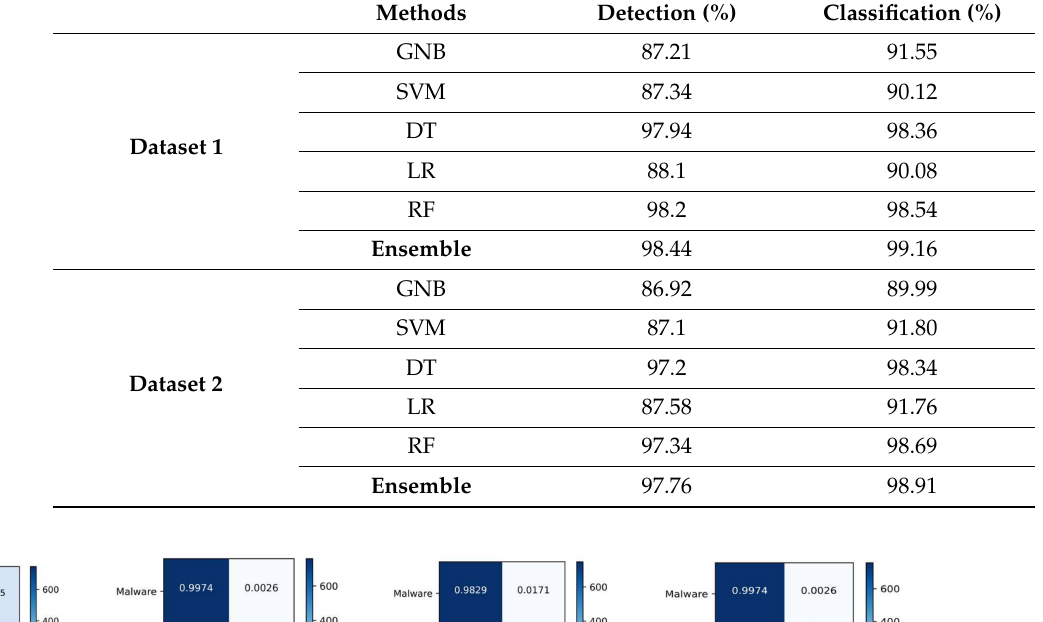
Table 5. Malware detection and classification accuracy using both datasets.